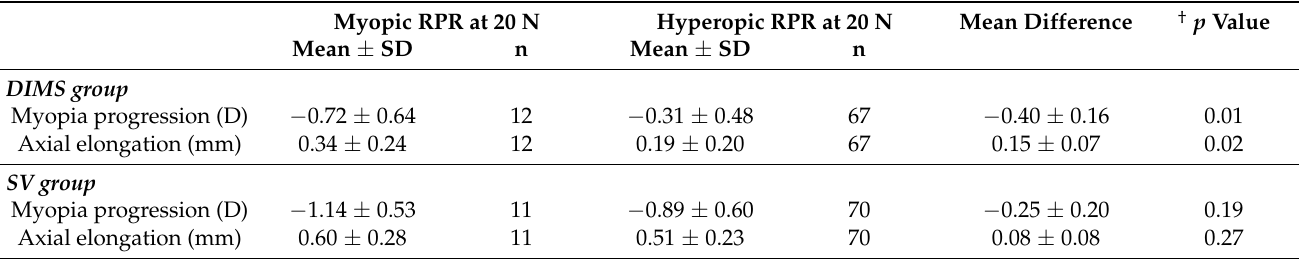
Table 3. The difference in myopia progression and axial elongation between children with myopic RPR and hyperopic RPR at 20 N in the DIMS and SV group,